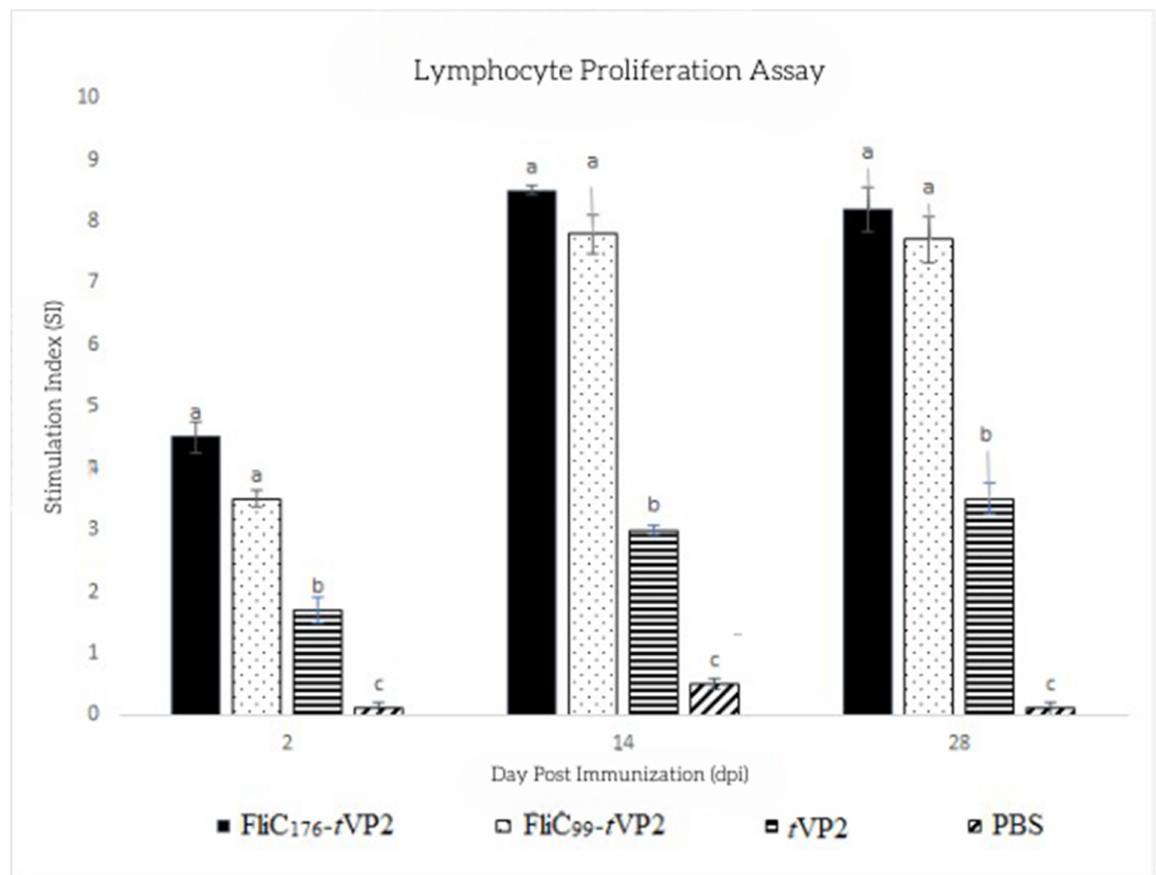
Figure 5. Each group’s chickens ( n = 3) were immunized with the FlIC176-tVP2, FliC99-tVP2, tVP2 and PBS. PMBCs were collected, and after stimulation with tVP2, lymphocyte proliferation was analyzed using an MTT assay. Data are presented as mean ± SEM. Different letters indicate significant differences ( p < 0.05) between treatment groups at the same time